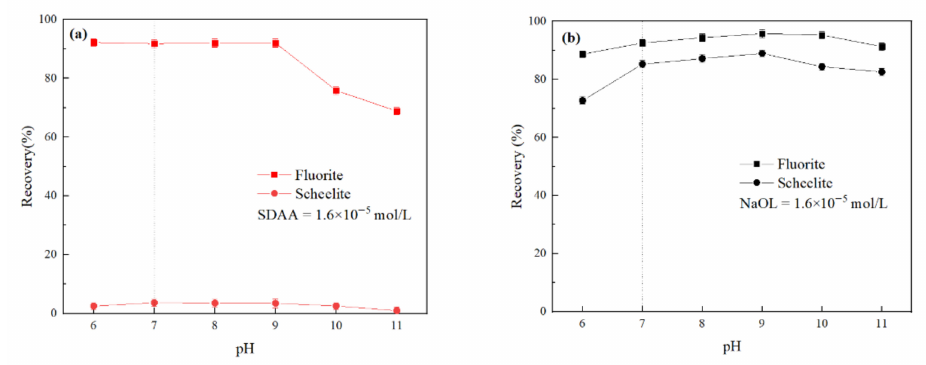
Figure 2. ( a ) Recoveries of fluorite and scheelite as a function of the pulp pH using SDAA as a collector and ( b ) recoveries of fluorite and scheelite as a function of the pulp pH using NaOL as a collector.